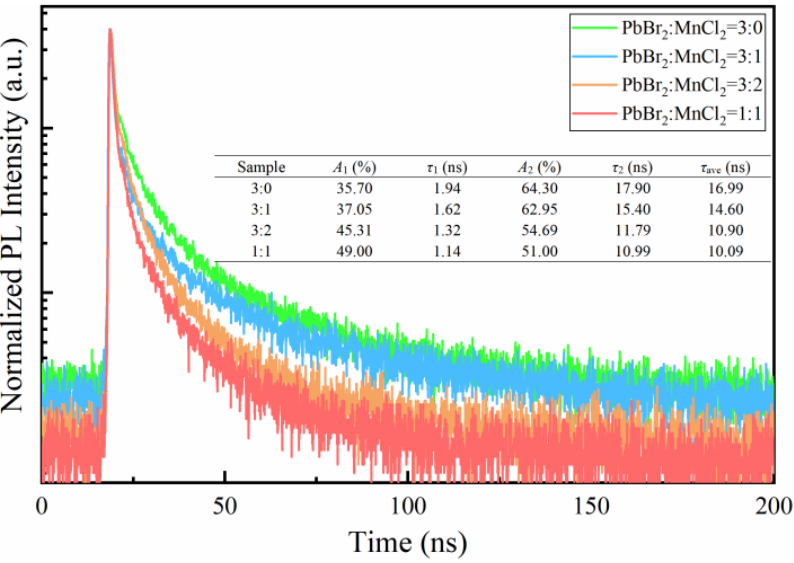
Figure 5. Time-resolved PL decay curves of the samples prepared by different PbBr 2 /MnCl 2 ratios.